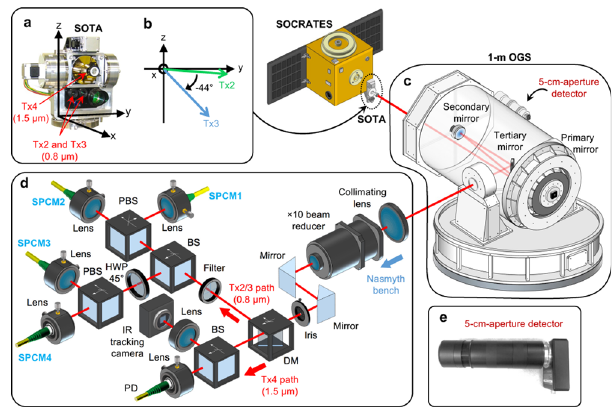
Fig. 2 Transmitter and receiver systems. a SOTA terminal (18 cm width × 11 cm depth × 27 cm height). b Con fi guration of the two linearly polarized laser diodes Tx2 and Tx3 equipped in SOTA. c OGS' 1-m aperture telescope. d Quantum receiver for detecting 0.8 μ m quantum signals transmitted from Tx2 and Tx3. The 1.549 μ m circularly polarized beam path after the 1-m telescope was for satellite tracking and separated from the 0.8 μ m path by using a dichroic mirror. e 5-cm aperture detector coaxially installed on the telescope to detect 1.549 μ m classical signals transmitted from Tx4 for classical measurements. DM: dichroic mirror, PD: photodetector; IR: infrared; BS: beam splitter; PBS: polarizing beam splitter; HWP: half-wave plate; SPCM: single-photon counter module. The four SPCMs are Si avalanche photodiodes with a detection timing resolution of 250 ps, and the total noise count rate (dark counts and background) from all SPCMs is 0.9 count/ms. Detector's afterpulse probability is 0.5%. Received photon counts were time-tagged by a time-interval analyzer with a timing resolution of 1 ps, generating a time-tagged photon-count sequence for each SPCM. Each detected bit from the received photon- count sequence is time-tagged with a resolution of 1 ns, including the timing jitter of the SPCM and other